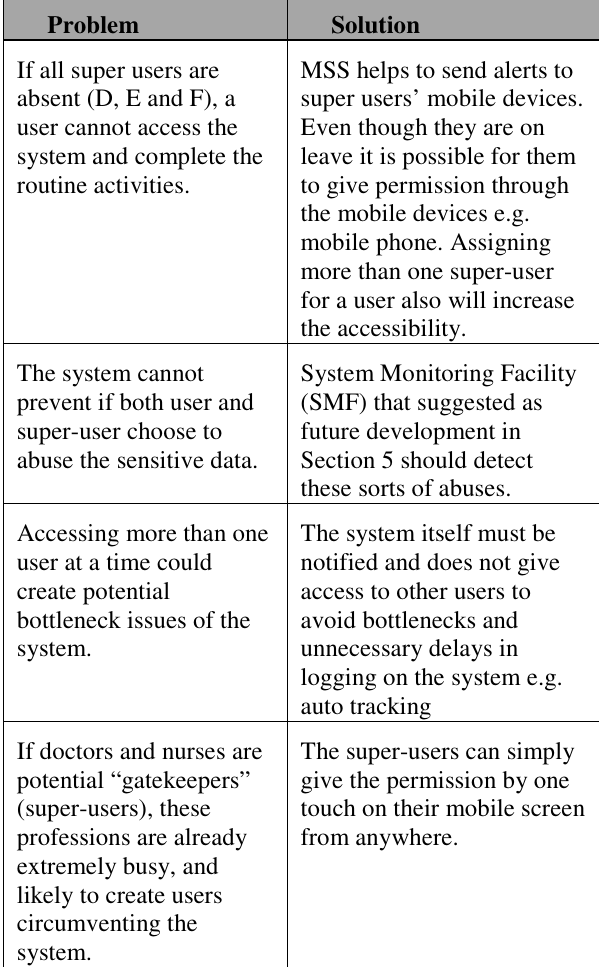
Table 2: Identified problems and the solutions of the proposed model Problem